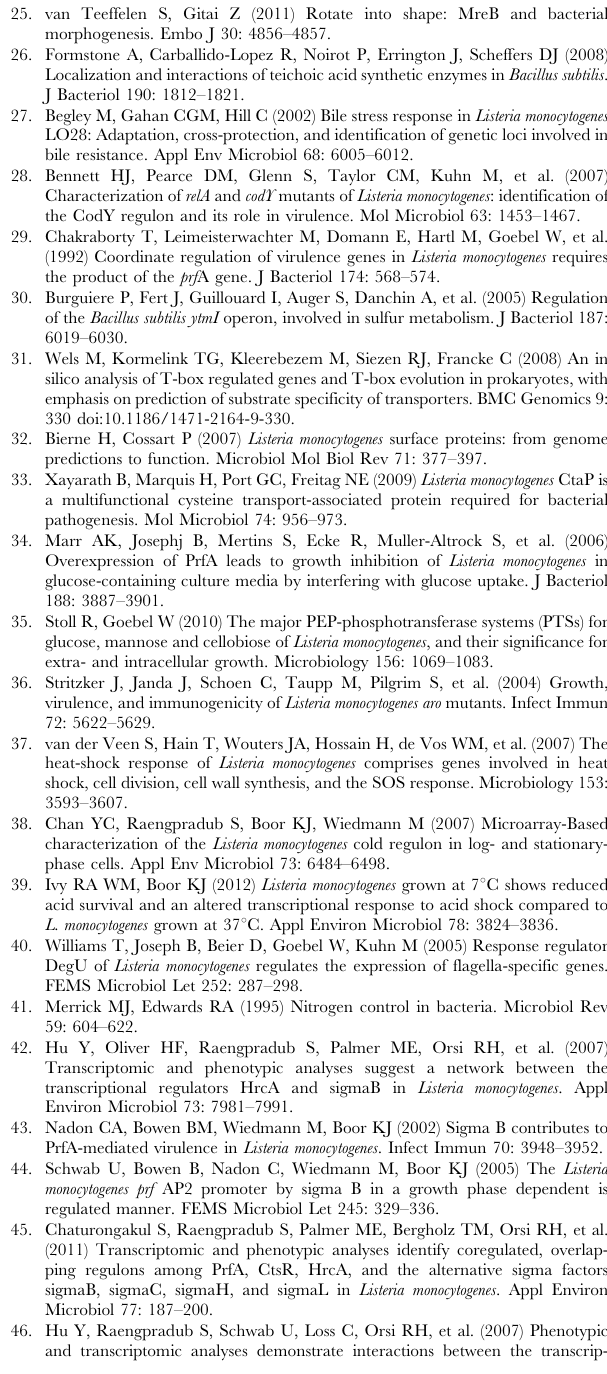
Table S4 List of genes with higher transcripts levels specifically in L. monocytogenes DG125A at 37 6 C. Table S5 List of genes with transcripts variations in the analysis DG125A versus EGD-e specific to 25 6 C. (PDF) Table S6 List of genes with transcripts variations in the analysis DG125A versus EGD-e specific to 37 6 C. (PDF)